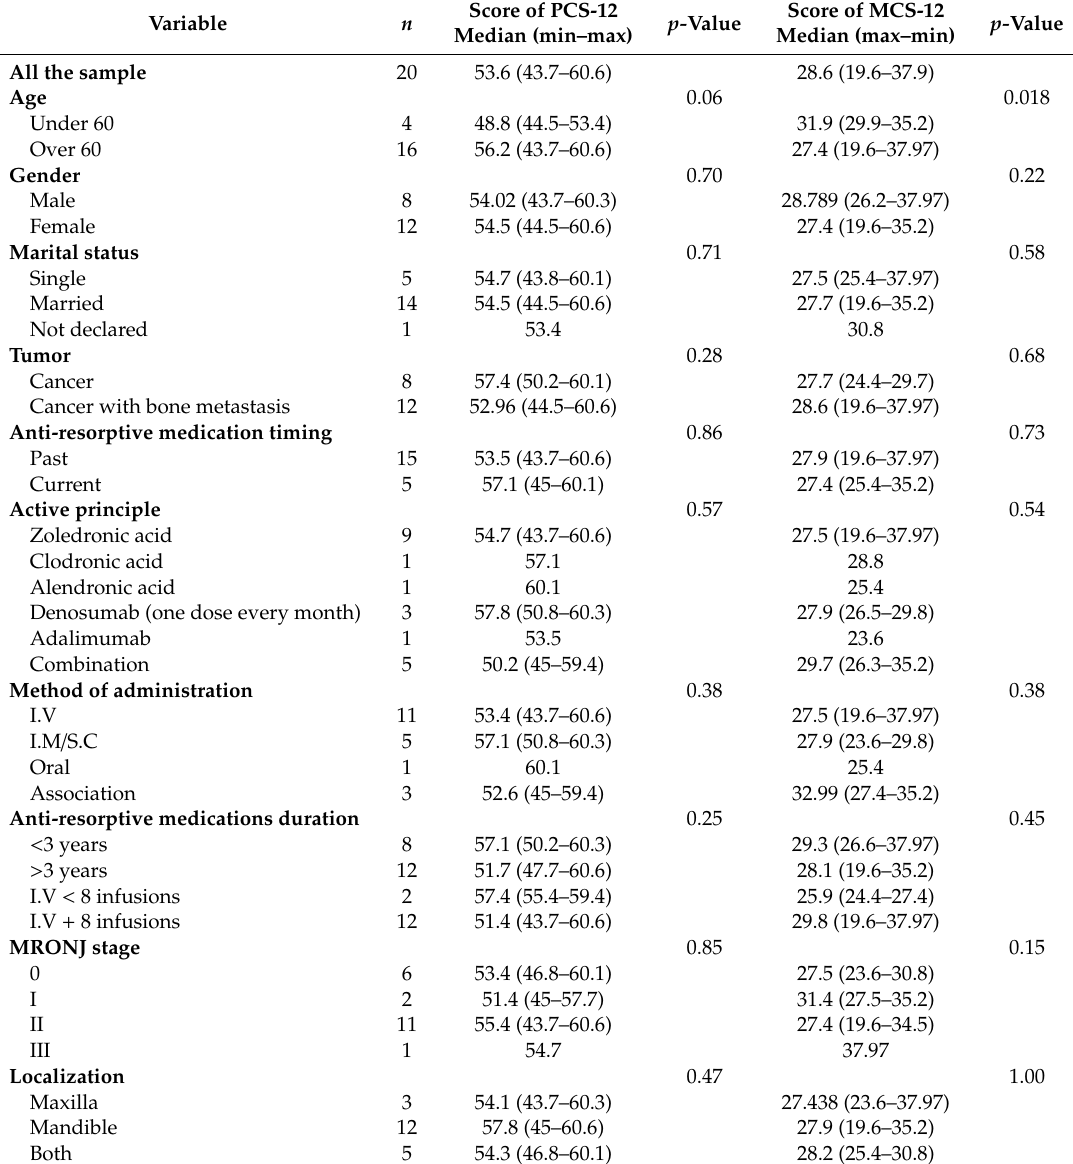
Table 2. Median 12-item Short Form Survey (SF-12) component scores by patients’ characteristic variables.